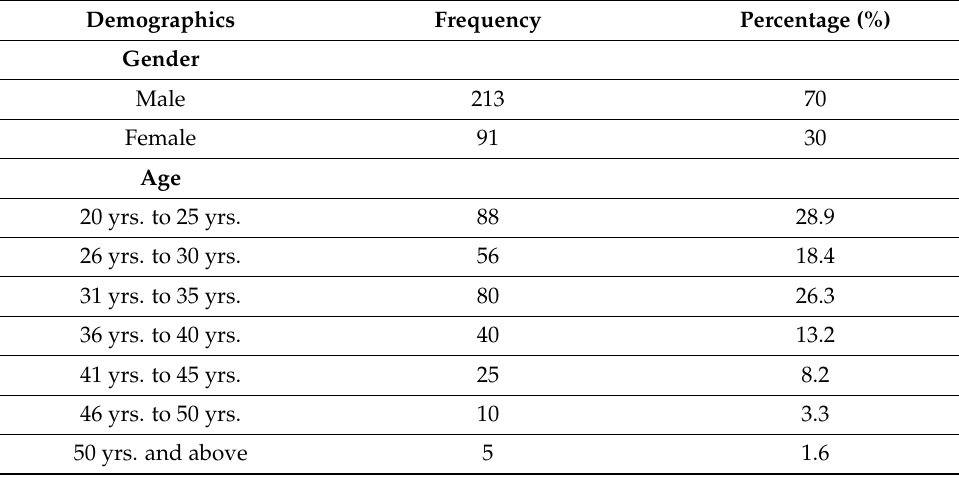
Table 1. Demographic profile of the